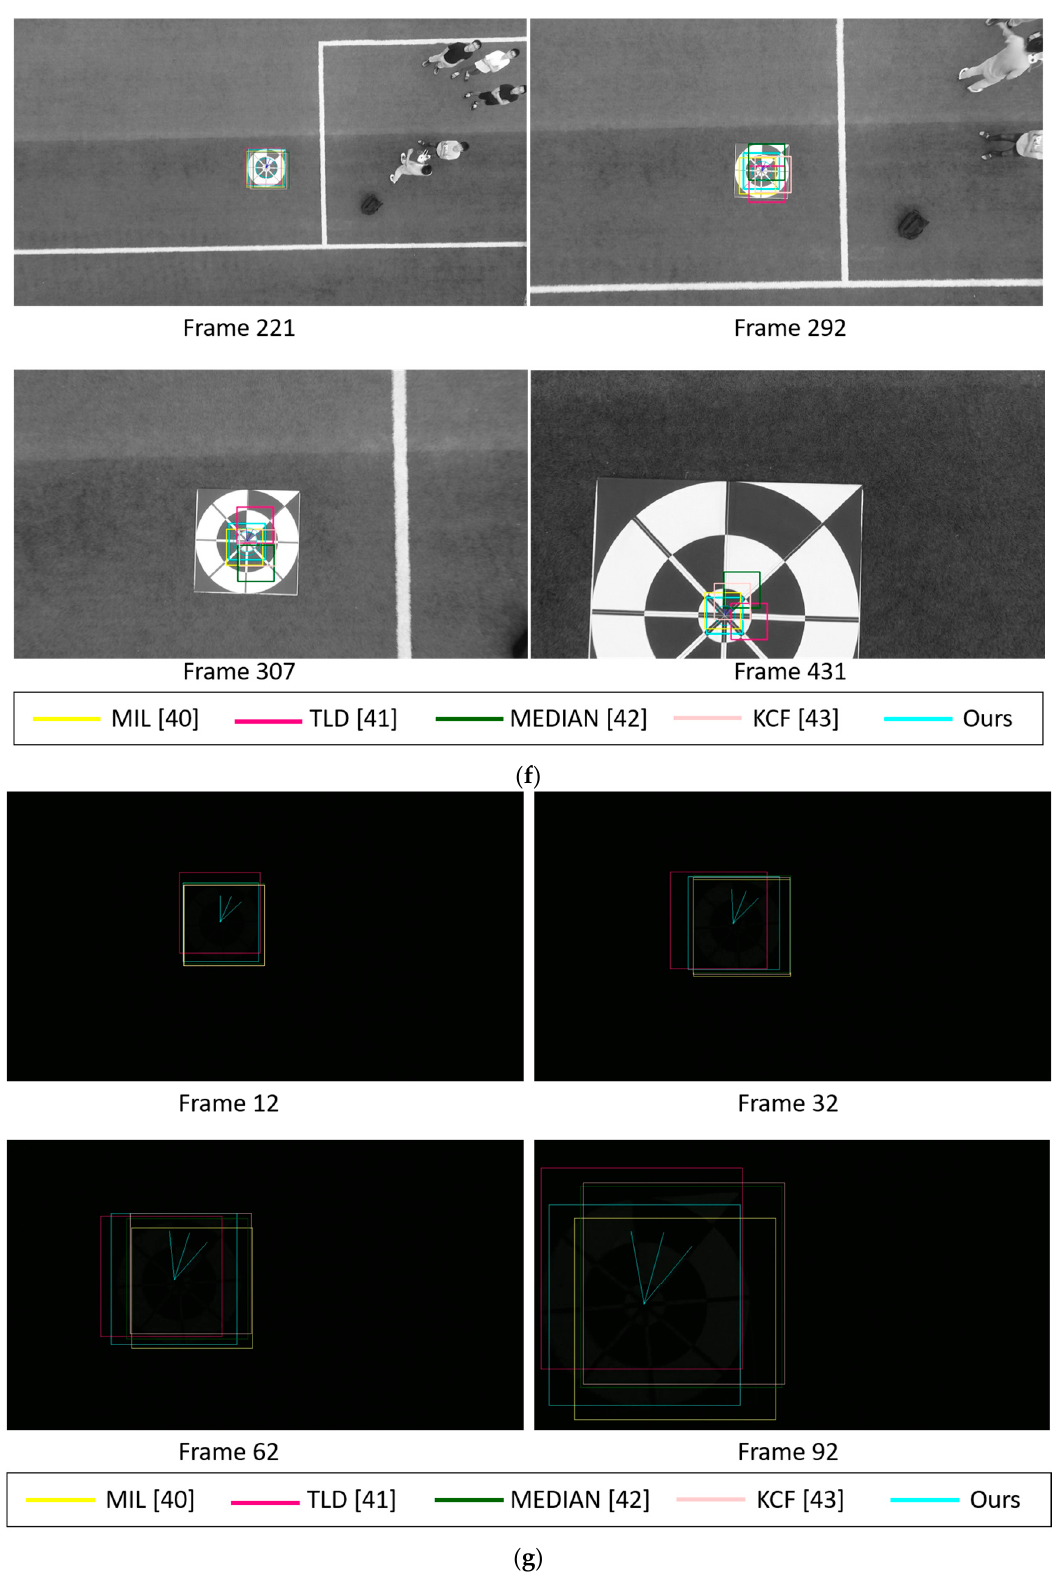
Figure 14. Marker detection examples obtained using our method and previous methods using sub-database 1 including videos captured ( a, b ) in the morning, ( c, d ) in the afternoon, ( e, f ) in the evening, and ( g ) at night.